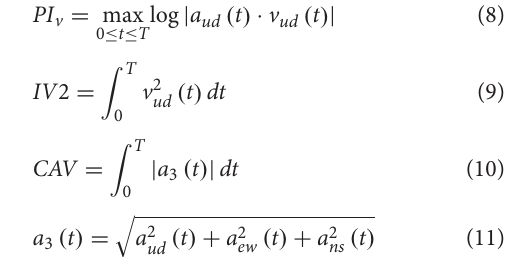
where d ud ( t ), v ud ( t ), and a ud ( t ) are the vertical components of